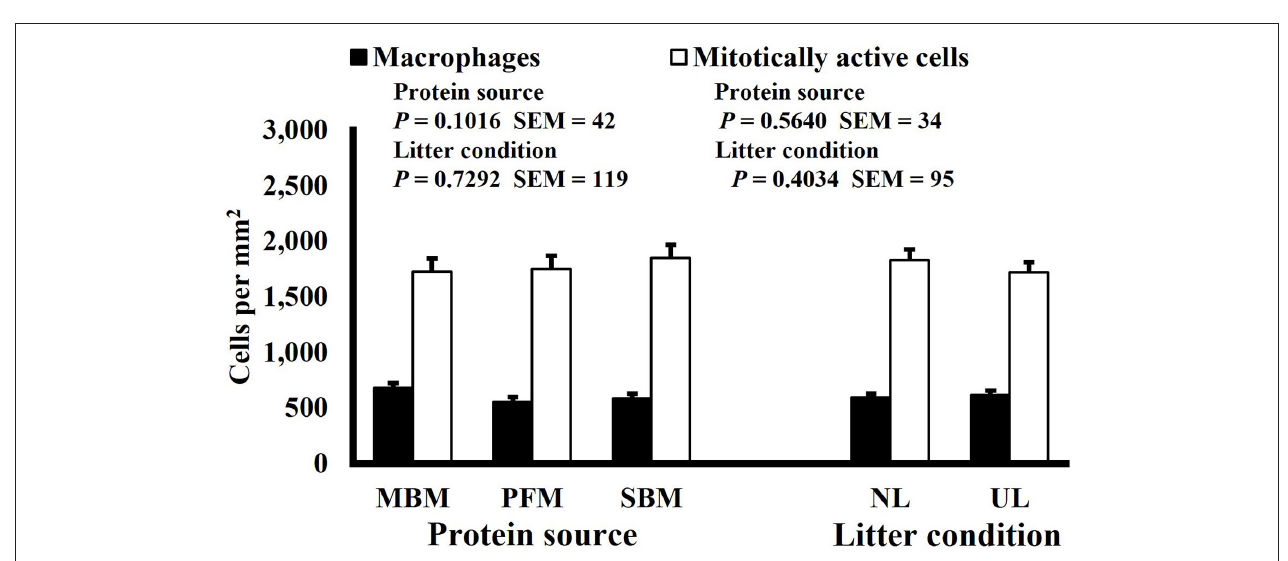
FIGURE 5 | Effect of dietary protein source and litter condition on macrophage (KUL01 + ) and mitotically active (BrdU + ) cell densities (cells per mm 2 ) in the duodenum of 21-d-old broilers ( n = 36 per sampling d, 6 birds per treatment). MBM, meat and bone meal; PFM, 50% poultry by-product and 50% feather meal blend; SBM, soybean meal; NL, new litter; UL, used